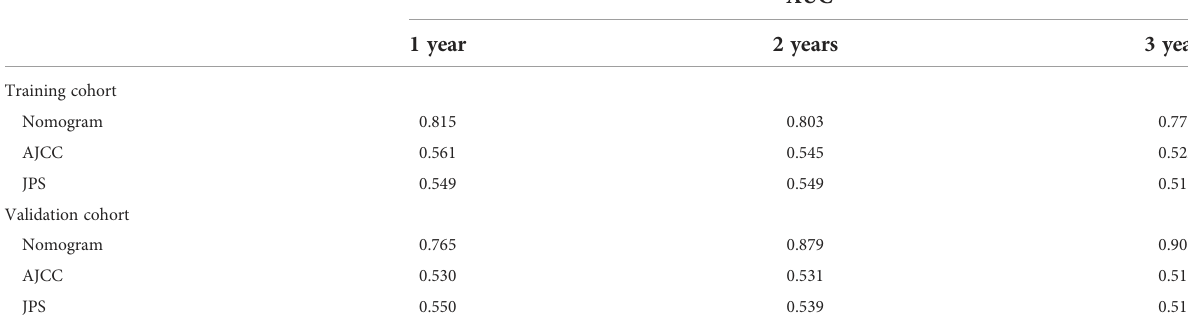
TABLE 4 Prognostic performance of different models for predicting liver metastasis after radical resection.